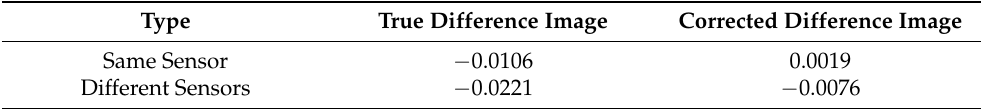
Table 7. Statistics of the pixel’s mean values of the difference images from same sensor and from different